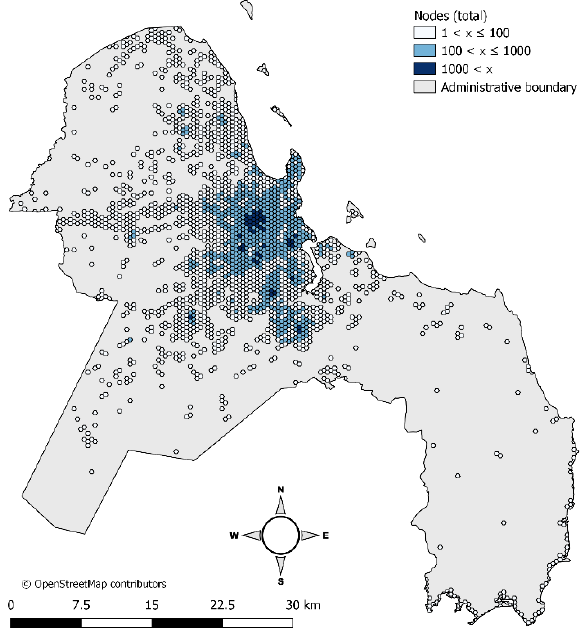
Figure 4. Dar es Salaam grid classified according to the number of OSM nodes (map data © OpenStreetMap contributors).